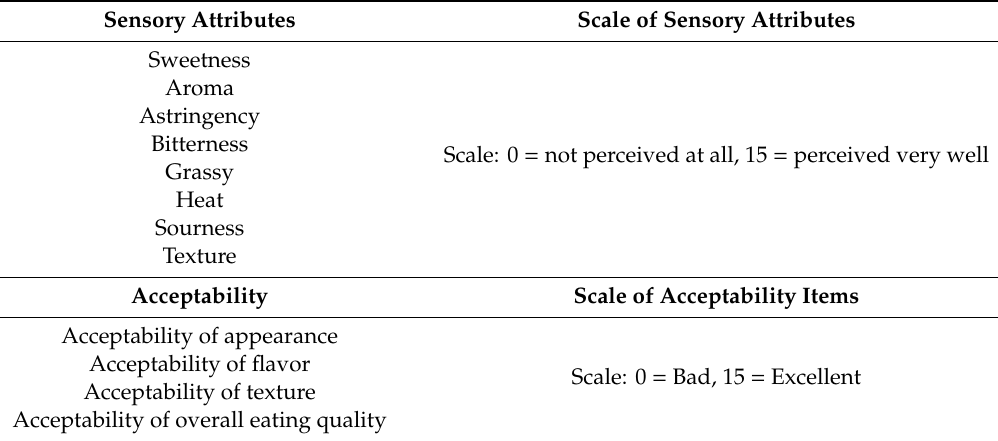
Table 1. Sensory attributes and acceptability items collected during the consumer test. The 12 microgreens were assessed by means of nine sensory attributes and four acceptability items and using 15-cm labelled magnitude scales (LMS). Sensory Attributes Scale of Sensory Attributes Sweetness